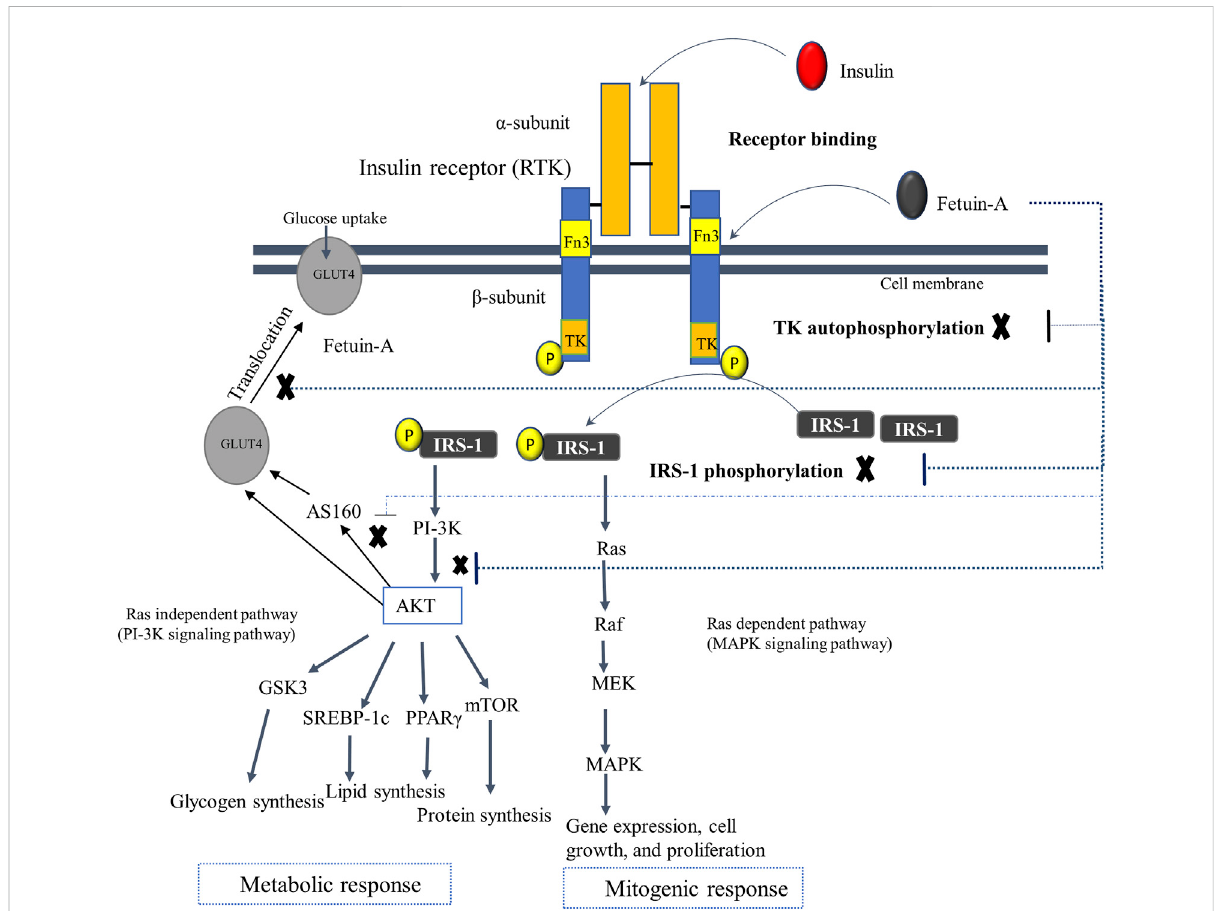
FIGURE 4 The postulated regulatory mechanism of fetuin-A in insulin signaling. Fetuin-A interacts with the tandem Fn3 situated in the extracellular domainofthetransmembranesubunitoftheRTK,whichisawayfromthebindingsiteofinsulin.TheD3domainoffetuin-Aispostulatedtobindwith theRTK.Theinteractionoffetuin-Awithinsulinreceptorswitchesofftheintracellularinsulinsignalingpathwaybyimpairingtheautophosphorylation oftyrosinekinaseandIRS-1,aswellaslowersglucoseuptakebyinhibitingphosphorylationofAKT,AS160,andGLUT4(asshownindottedlines), and thus controlling the overall insulin signaling pathway. Abbreviations: As160, Akt substrate of 160 kDa; Fn3, fi bronectin type 3 domains; GLUT4, glucose transporter 4; GSK3, Glycogen synthase kinase 3; IRS-1, insulin receptor substrate-1; MAPK, Mitogen-activated protein kinase; MEK, MAPK kinase; PI-3k, Phosphoinositide 3-kinase; TK, Tyrosine